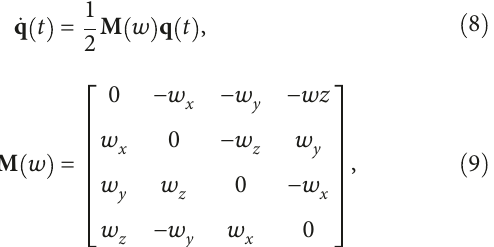
Figure 6. Traditional zero-velocity detection results contain a lot of pseudomoving phases, which results in inaccurate location calculations. The improved gait detection algorithm segmented the gait e ff ectively.